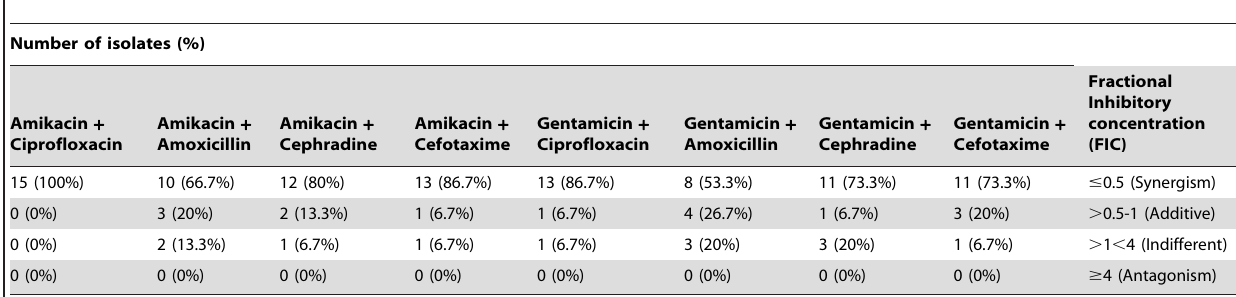
Table 6. Effect of combinations of aminoglycosides on antibacterial activity by Checkerboard titration.